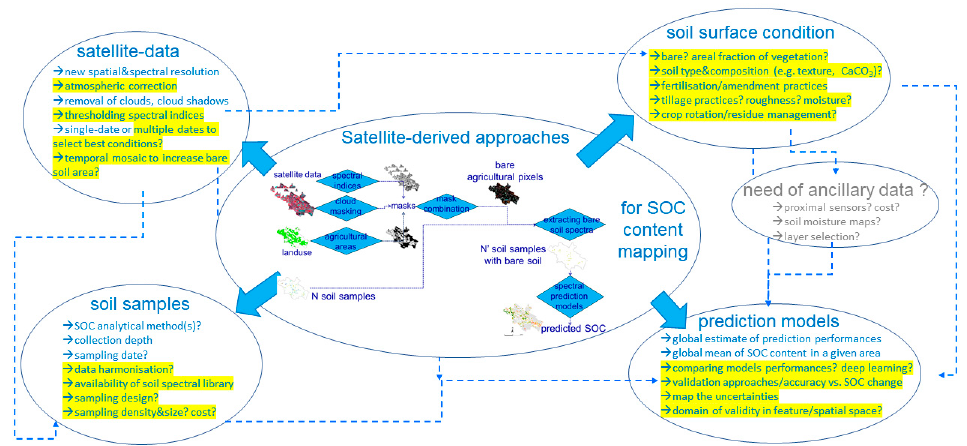
Figure 7. Diagram of the main limitations and future research directions referring to satellite-derived approaches for SOC content mapping. Hot topics are underlined in yellow.